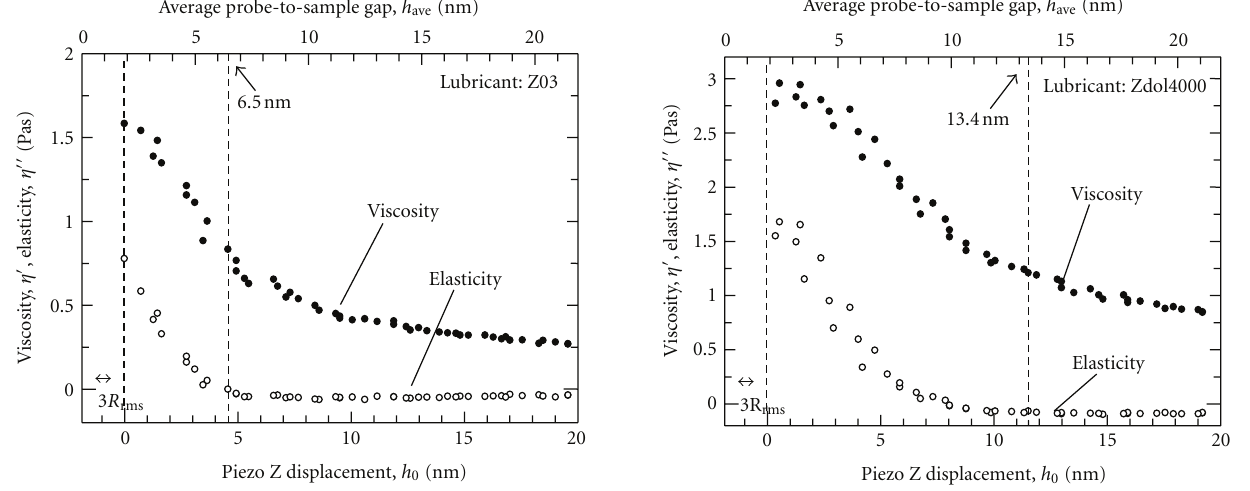
Figure 7: E ff ect of the shearing gap on the viscosity η (cid:4) and elasticity η (cid:4)(cid:4) measured with the Z03 lubricant [24].